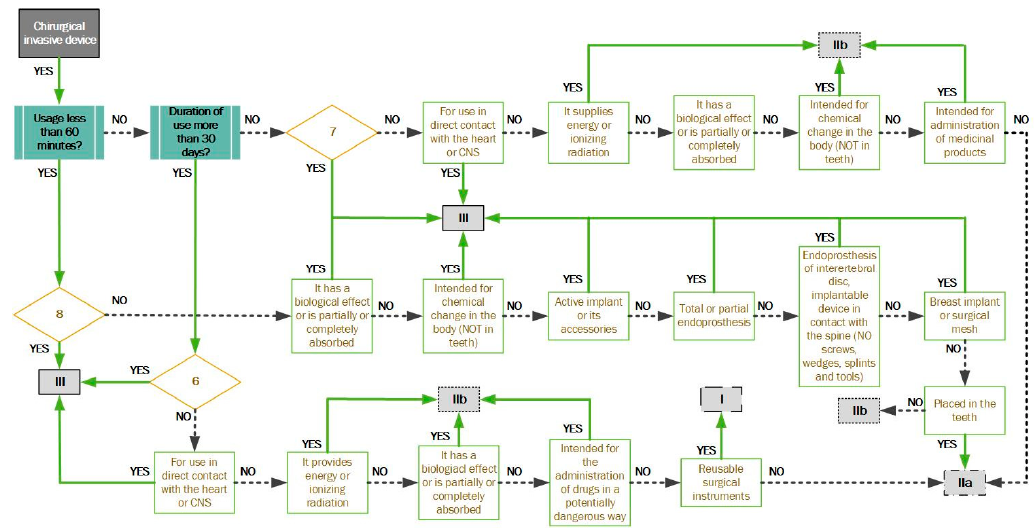
Figure 5: If the fourth phase does not meet the classification, the manufacturer continues to the fifth phase. Rule 6 —surgically invasive devices for transient use; Rule 7 —surgically invasive devices for short term use; Rule 8— surgically invasive devices for long term use and implantable (including any device administering medicinal products, surgical mesh, or spinal disc).